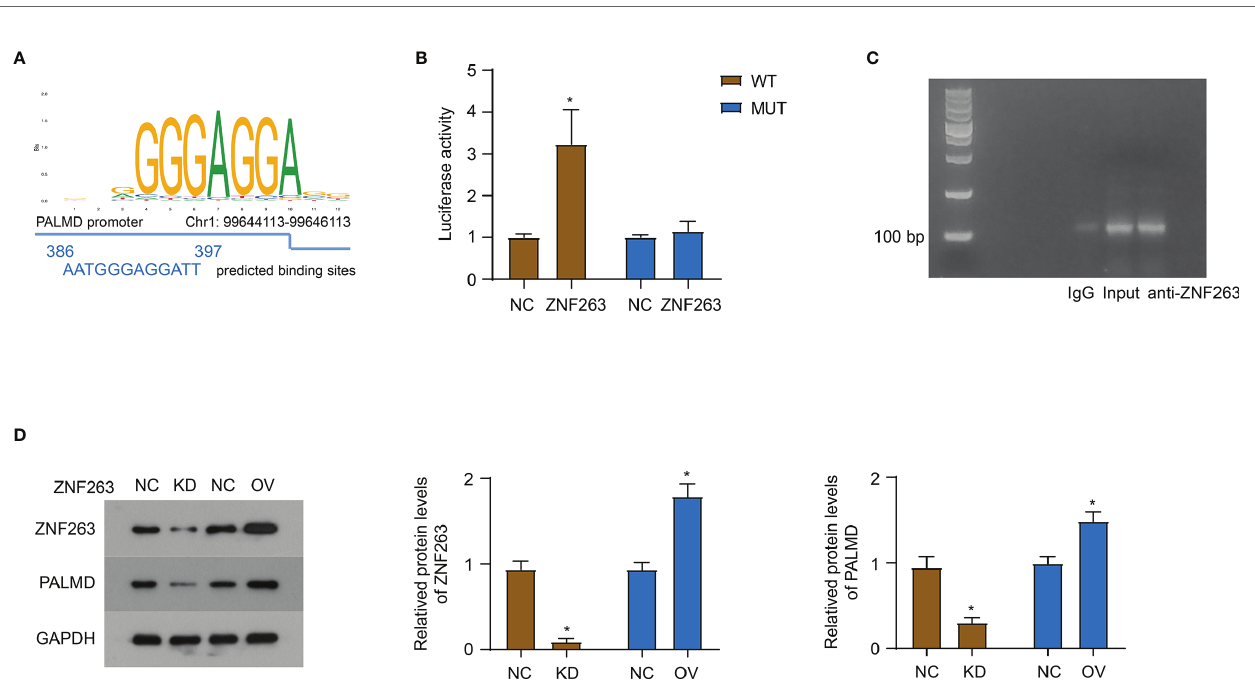
FIGURE 5 | ZNF263 is responsible for the transcriptional regulation of PALMD. (A) ZNF263 was predicted to be a transcription factor binding to the PALMD promoter, and the binding site was AATGGGAGGATT. Data from JASPAR databases. (B) Luciferase reporter assay in 92-1 cells. (C) PCR and agarose gel ampli fi cation and detection of DNA sequences bound to the ZNF263 protein in 92-1 cells overexpressed ZNF263. (D) The effect of ZNF263 down- or up- regulated expression on PALMD protein expression was detected in 92-1 cells with western blot. *P <